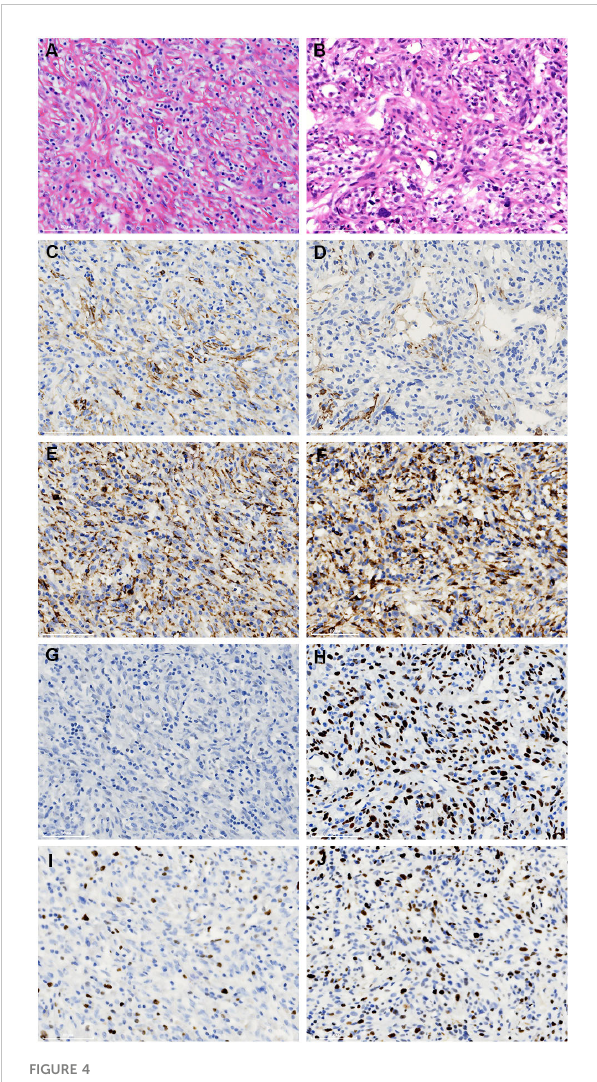
FIGURE 4 Comparison of the immunostaining features of the bland (A, C, E, G, I) and atypical spindle cells (B, D, F, H, J) . They are focally immunoreactive with SMA (C, D) and CD68 (E, F) . However, the staining of p53 is negative in the former (G) , while strongly expressed in the latter (H) . In addition, an increased ki-67 index is noticed in the atypical spindle cells (I, J) .